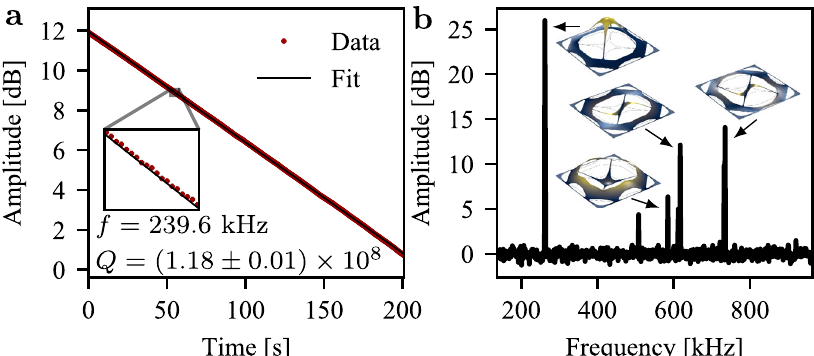
Fig. 4 Resonator result. a Mechanical ring-down measurement of the best measured sample corresponding to design D4. b Spectrum of a D1